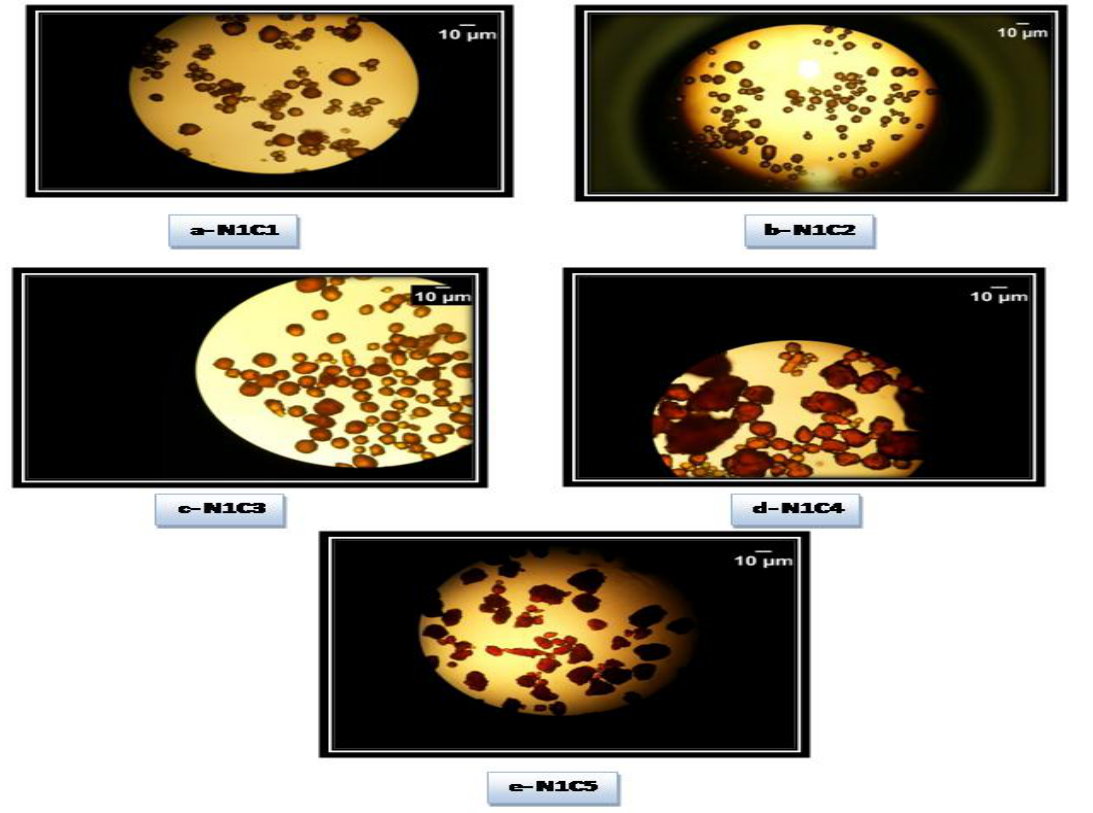
Figure (1): Optical microscope images of nystatin loaded